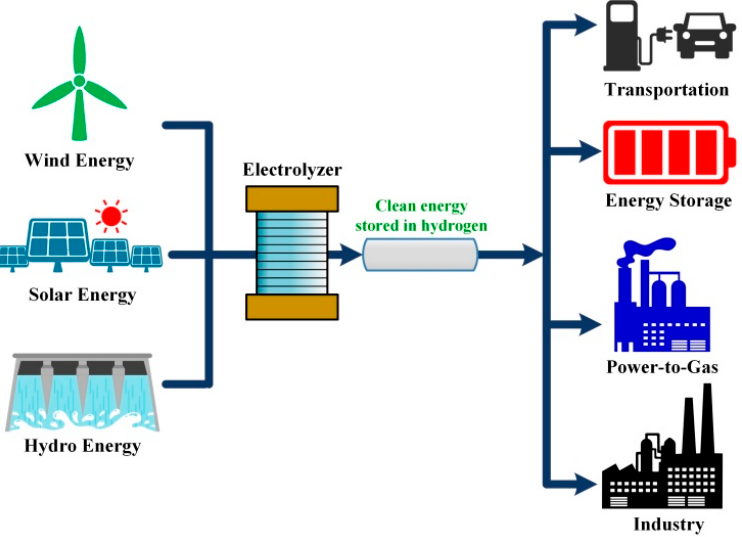
Figure 1. Overview of applications based on water electrolysis process supplied by renewable energy sources.